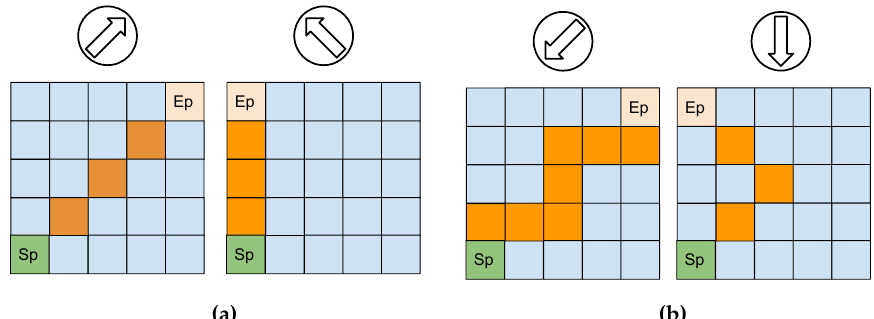
Figure 8. Four scenarios to exemplify possible paths from the start point (Sp) to the end point (Ep) taking account the wind directions. In ( a ) it is a downwind situation, so it is possible to reach the goal by following a straight path. On the other hand, in the two situations in ( b ) the wind and boat directions are contrary to each other, so it is necessary for the boat to perform a zigzag path to achieve the end point.